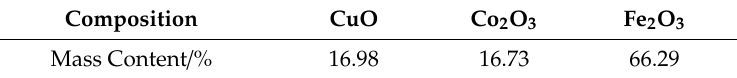
Table 5. Experimental values and fitted values of spinel materials.